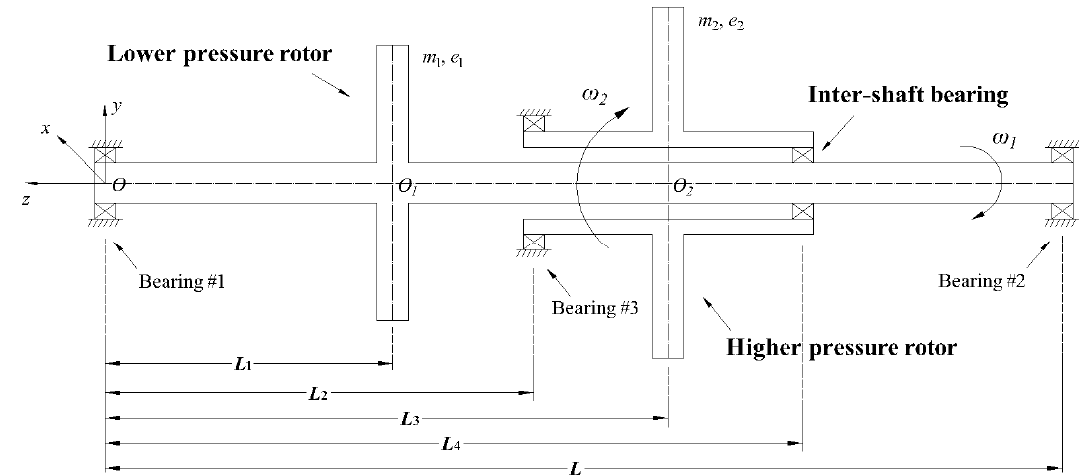
Figure 1. Configuration of a typical dual-rotor system.